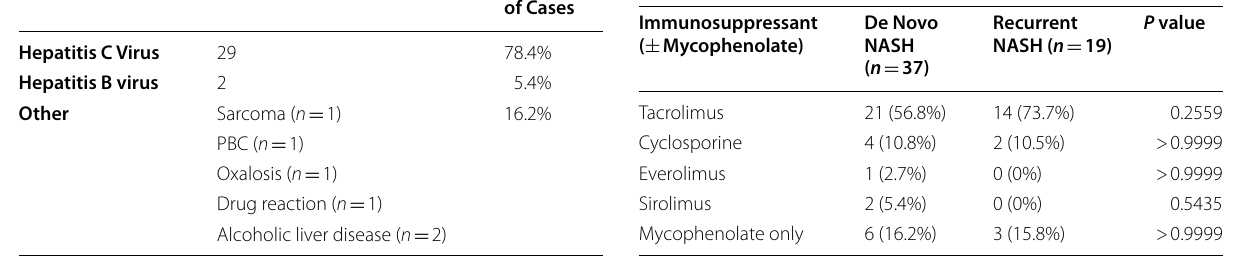
Table 1 Pre‑transplant Characteristics of de novo NASH